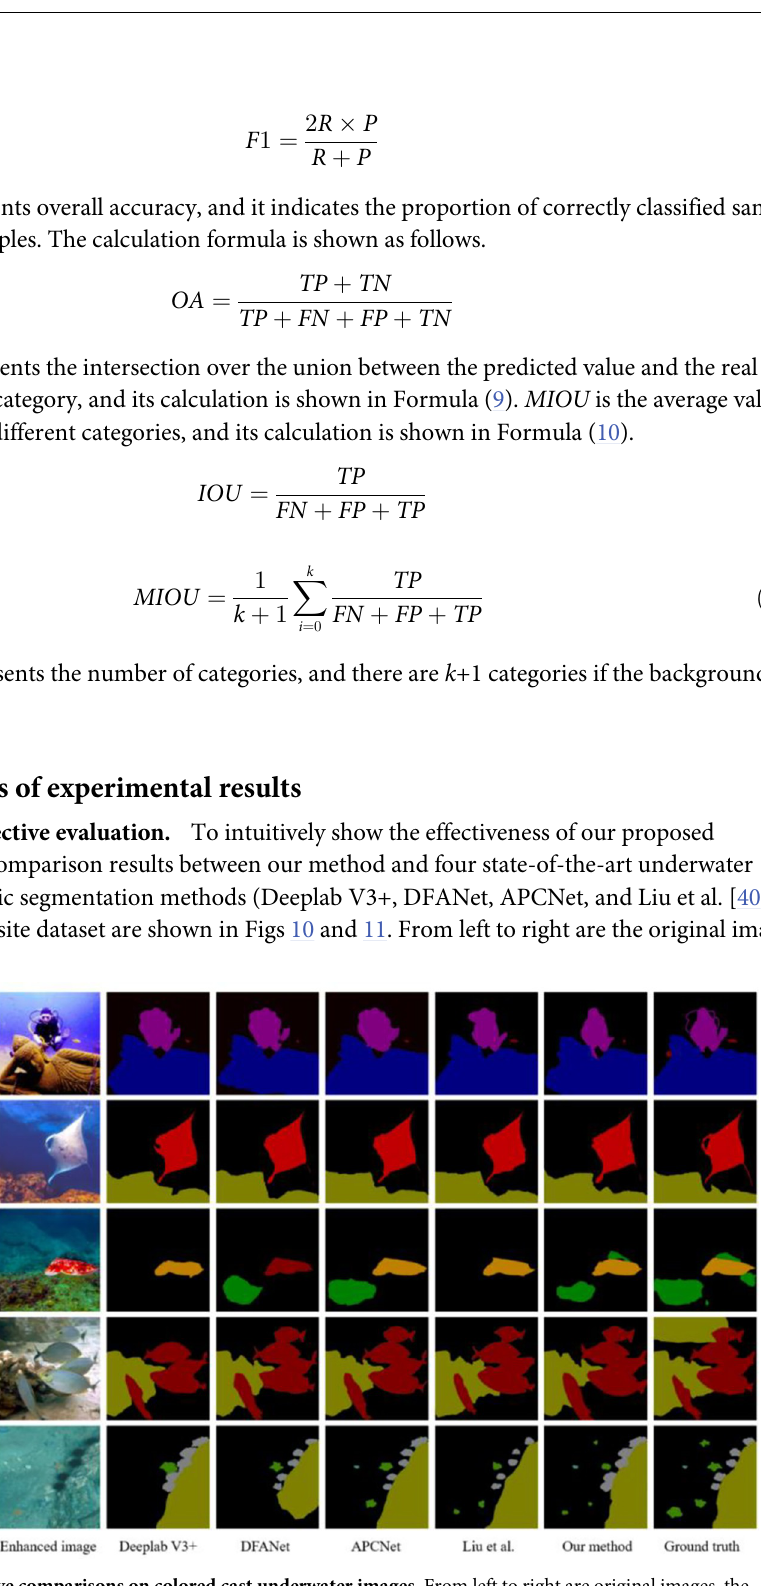
Fig 10. Qualitative comparisons on colored cast underwater images. From left to right are original images, the enhanced images, and the results generated by Deeplab V3+, DFANet, APCNet, the method proposed by Liu et al., our method, and the ground